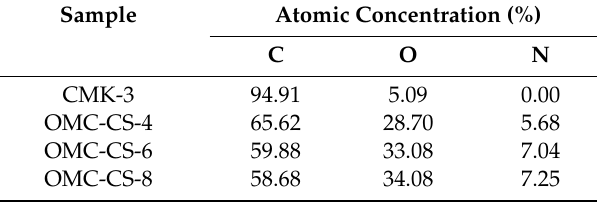
Table 2. Surface elemental composition of CMK-3 carbons and OMC-CS-4,6,8 from XPS N 1s spectra. Sample